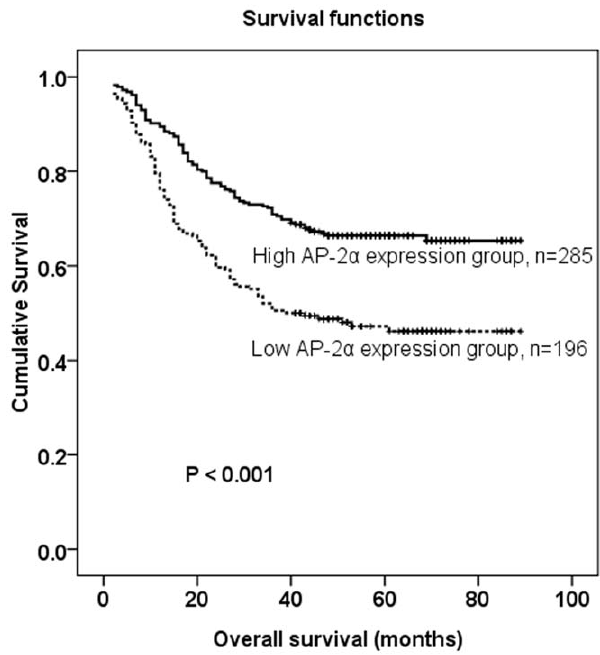
Figure 4. Kaplan–Meier survival curves of gastric cancer patients (n=481) after surgical resection. Decreased AP-2 a expression correlated with poor patient survival. Patients in high AP- 2 a expression group exhibited significantly better survival than the low AP-2 a expression group (log-rank test: P , 0.001).